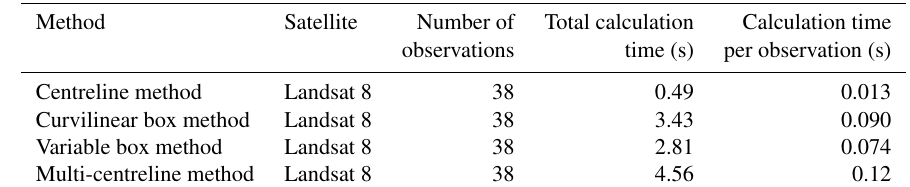
Table 4. MaQiT performance metrics.